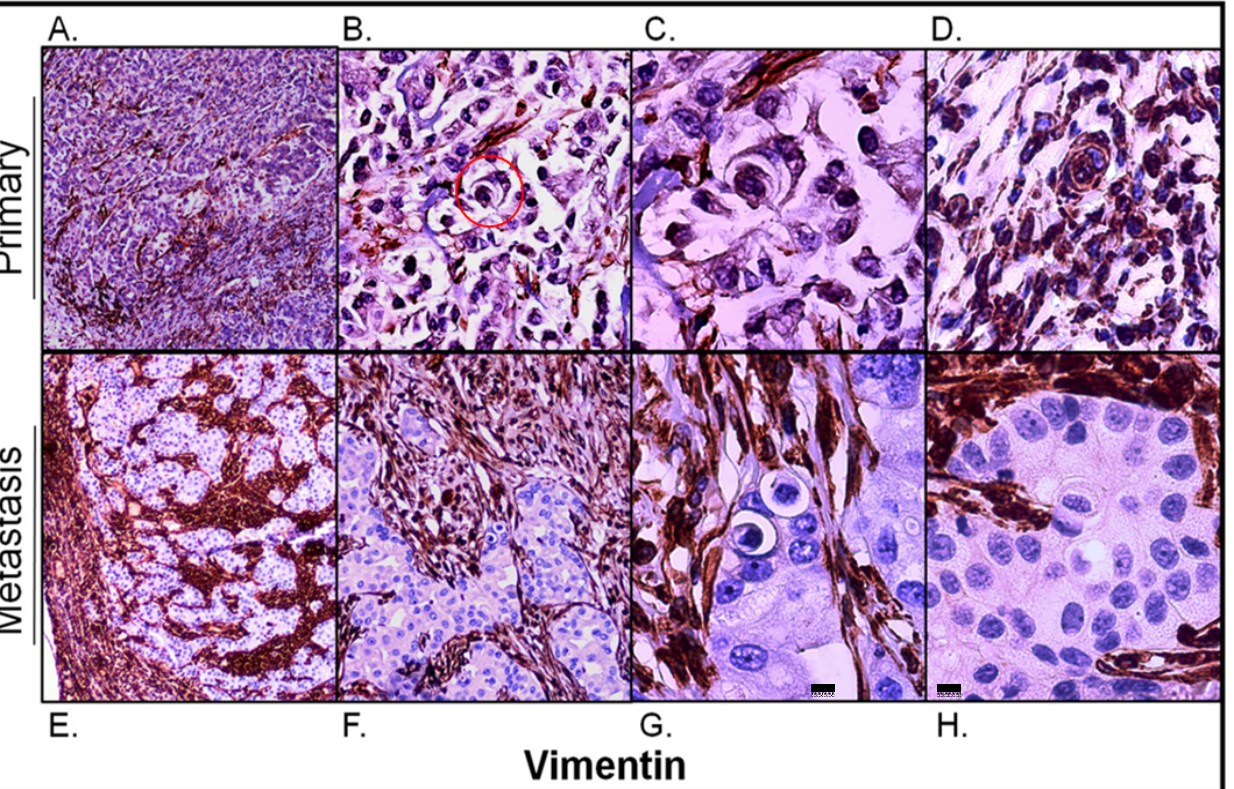
Figure 6. Vimentin expression in the primary lesion and lymph node metastasis. ( A ) Primary le ‐